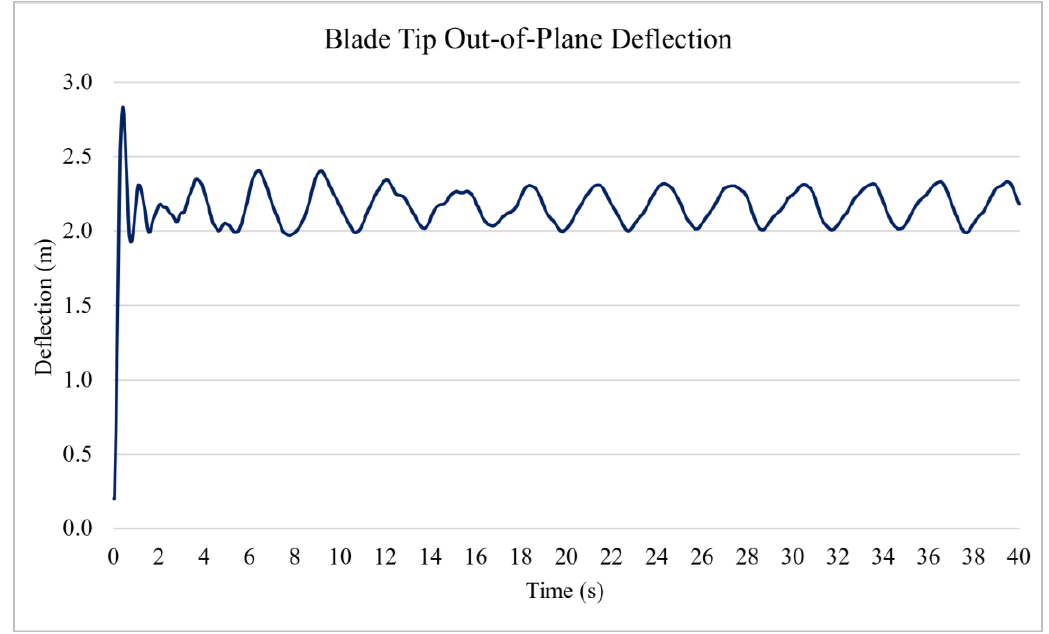
Figure 4. Blade Tip Out-of-Plane Deflection - 1% Turbulence